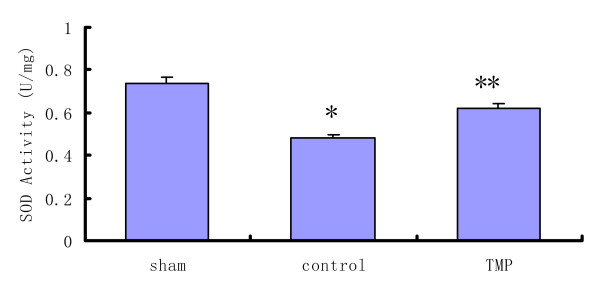
Effects of TMP on SOD Activity at the 48th hour reperfusion. The Cu/Zn-SOD activity of spinal cord in sham group, Control group and TMP group was determined as described under "Methods". Average value and SD are shown, N = 3.*P < 0.01, vs sham group; **P < 0.01, vs control group.